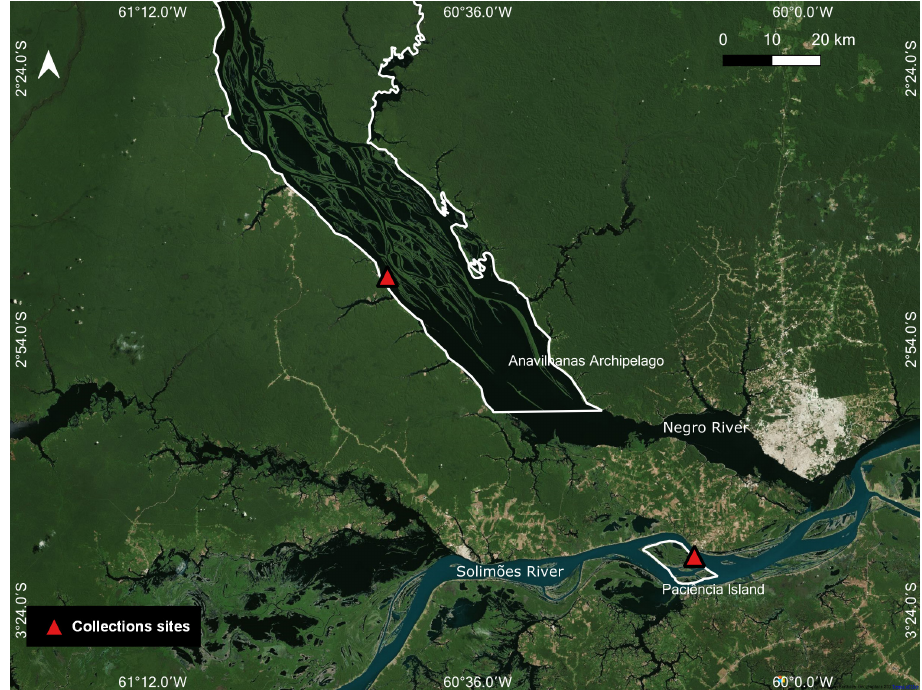
FIGURE 1 | Location of study areas (in white line) and collection points (red triangles) in Amazonas, Brazil. QGIS 2.18 and Bing © 2019 Microsoft Corporation Geographic